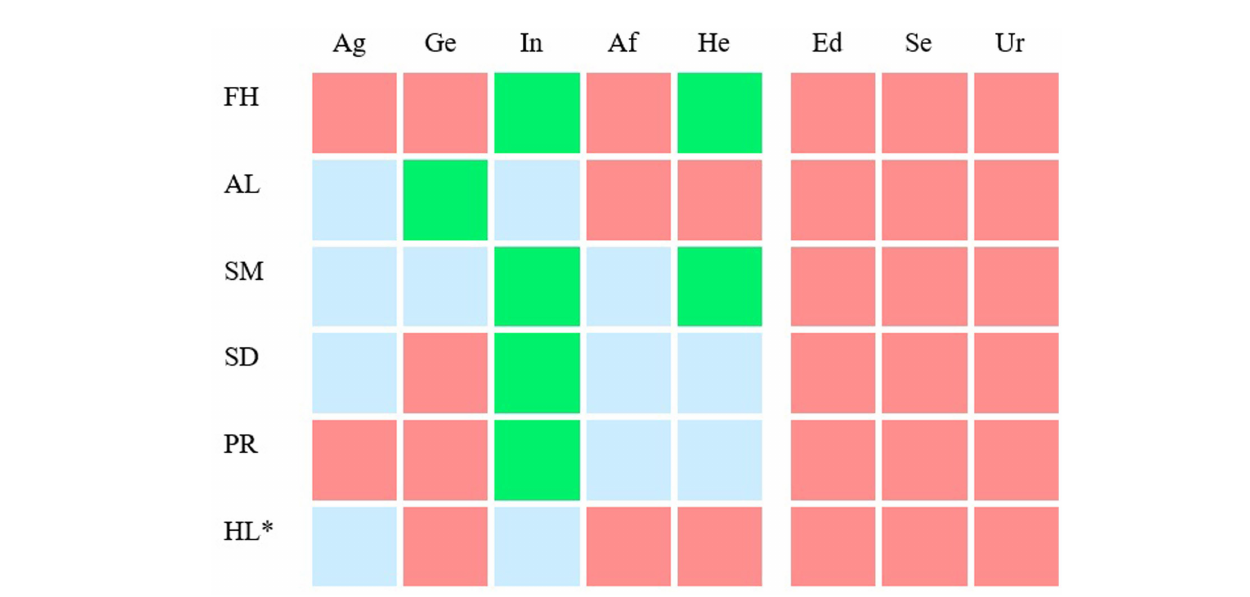
FIGURE 1 Background variables that predict participants’ interest in personalized medicine related subtopics and the exhibition’s working title. For six subtopics (lines 1–6) the relationship between average interest in a subtopic and eight background variables (column 1–8) was visualized. FH, future health; AL, adapt lifestyle to stay healthy; SM, having a say in medical decisions; SD, share medical data to improve healthcare; PR, participate in scientific research to improve healthcare; HL, how do I live to be 200?; Ag, age; Ge, gender; In, individual science interest; Af, affinity for the health sector; He, general health; Ed, educational level; Se, self-reported SES; Ur, urbanization of the residential area. The color of the cells depict the background variables that do (green and blue) and do not (red) significantly predict participants’ average interest in a subtopic ( p < 0.001). Note that the effect sizes were small. The effect sizes ( eta^2 ) of the green cells are between 0.1 and 0.03 and of the light blue cells between 0.03 and 0.01. The exhibition related subtopic is marked with an asterisk (line